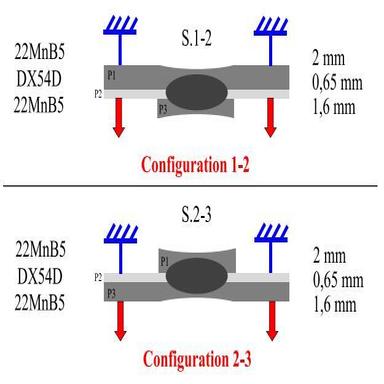
"1–2" and "2–3" configurations.